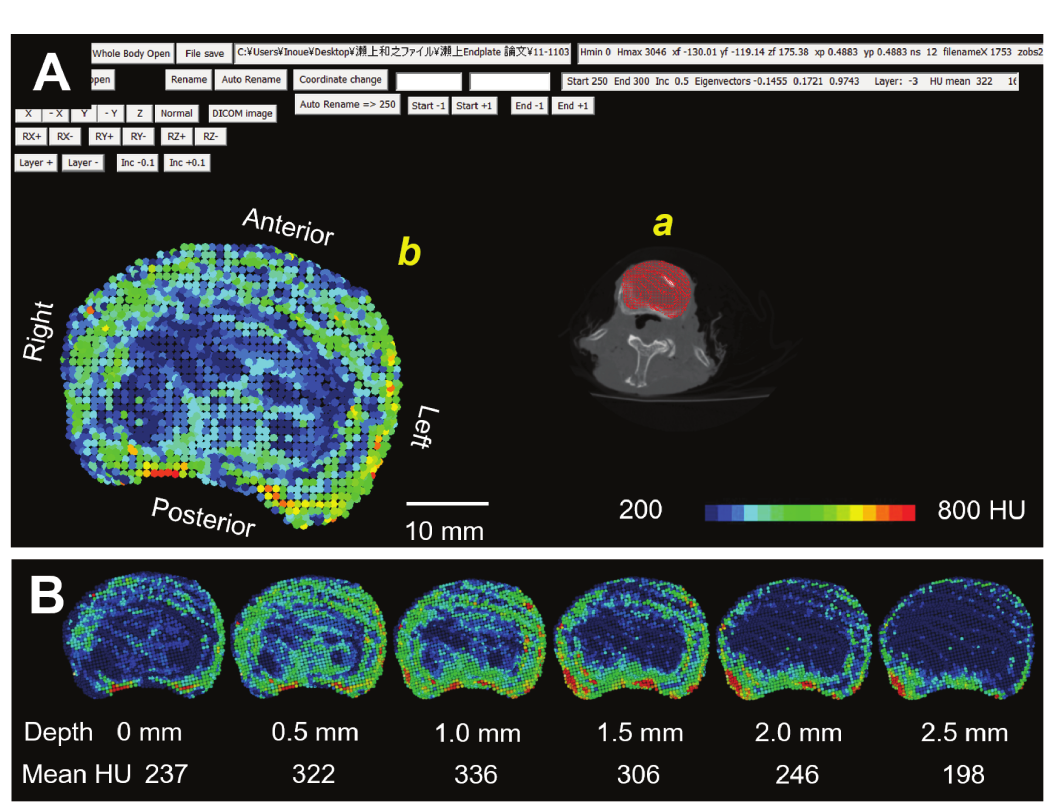
Fig 2. Measurement of Hounsfield Units (HU) across the endplate. A: screenshot of custom-written software for measurement to determine HU values at individual points consisting of a 3D endplate point-cloud model determined by a DICOM dataset. a; an axial CT slice (note; only one slice is shown on the screen although multiple slices are involved in the measurement). Red dots indicate location of the endplate point-cloud model. b; HU distribution on the endplate point-cloud model. Position and orientation of the point-cloud model can be changed in any increment. B: An example of changes in HU distribution and mean HU values at the surface and at depths 0.5–2.5 mm underneath the endplate surface. https://doi.org/10.1371/journal.pone.0259001.g002 PLOS ONE | https://doi.org/10.1371/journal.pone.0259001 October 27,